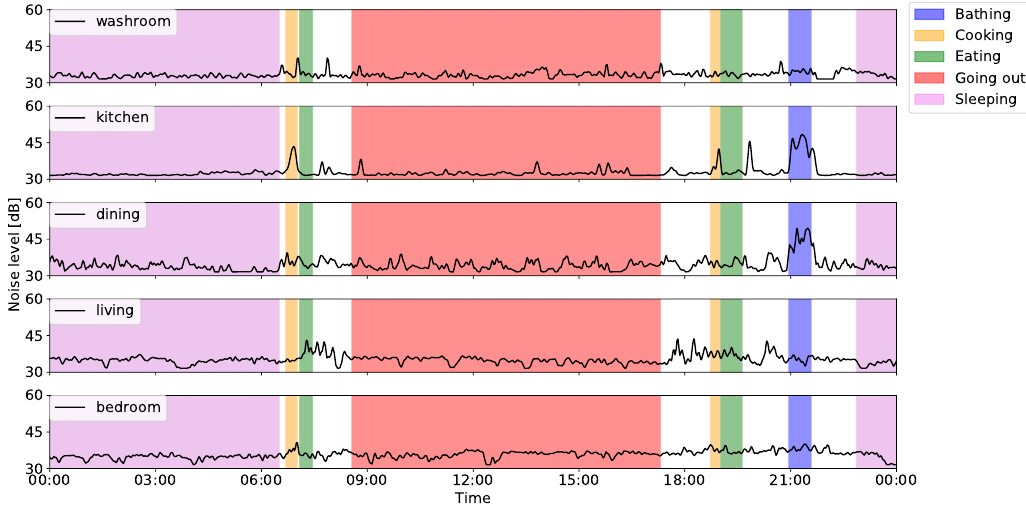
Figure 7. Example of collected ADL data (noise